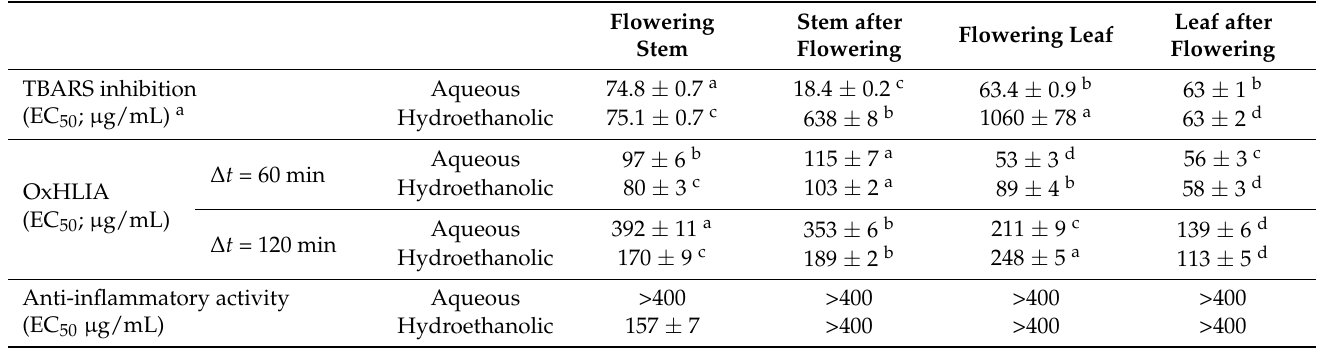
Table 5. Antioxidant and anti-inflammatory activities of the hydroethanolic and aqueous extracts of C. erecta (mean ± SD, n = 3